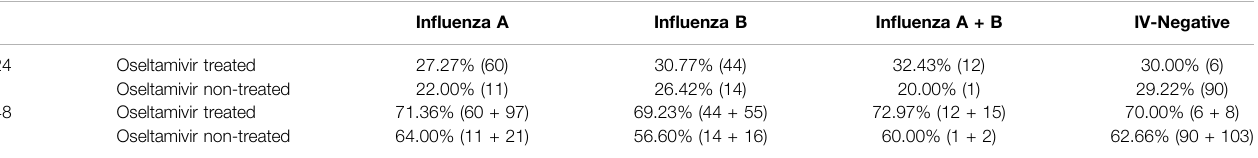
TABLE 4 | Percentage of patients afebrile within 24 and 48 h from onset of